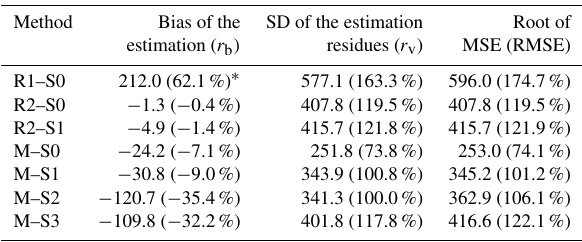
Table 2. Performance of the methods under different scenarios of data